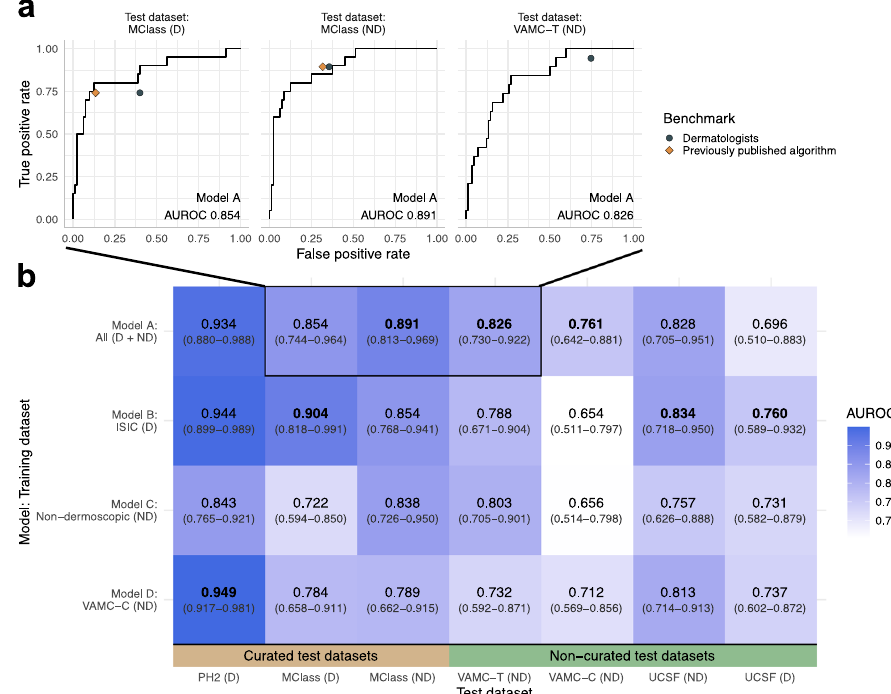
Fig. 1 CNN models achieve melanoma discrimination equivalent to or exceeding dermatologists across known and new benchmarks. a Model A performs comparably to mean of dermatologists (gray circles) and previously published algorithms 14,15 (orange diamonds) by ROC curves on the external MClass-D and MClass-ND benchmarks and our VAMC-T benchmark. No previous algorithm has been evaluated on VAMC-T. b AUROC is shown for each ensemble model and each benchmark, with darker shades corresponding to higher values. Labels show AUROC values and 95% con fi dence intervals, with highest per test dataset in bold. ROC curves from ( a ) are boxed. Differences in AUROC between models were not statistically signi fi cant. Abbreviations: AUROC area under the receiver operating characteristic curve, CNN convolutional neural network, D Dermoscopic, ISIC International Skin Imaging Collaboration, MClass Melanoma Classi fi cation Benchmark, ND Non-dermoscopic, PH2 Hospital Pedro Hispano, ROC Receiver operating characteristic, UCSF University of California, San Francisco,